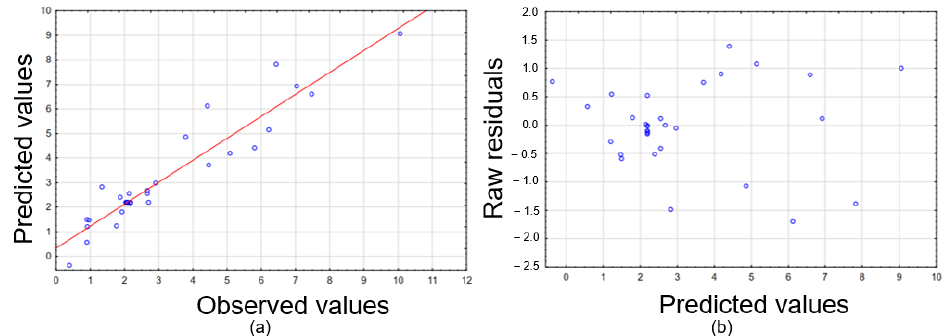
Figure 1. Predicted vs. observed values ( a ) and ( b ) raw residuals vs. predicted values for the specific energy consumption (SEC kWh g −1 ).